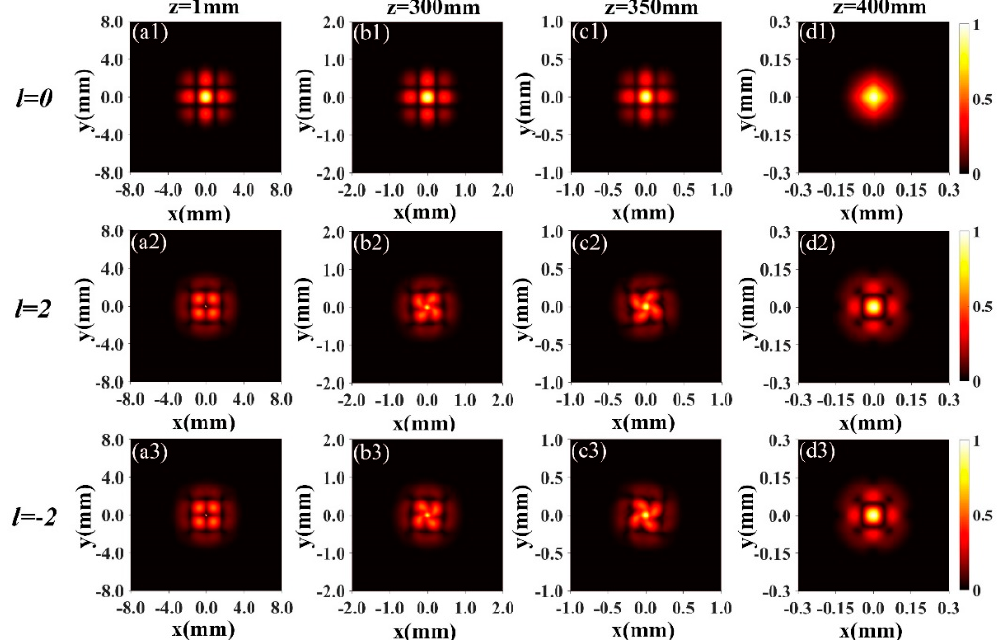
Figure 6. The modulus of the DOC ( | µ ( ρ ,0; z ) | ) of a focused HGCSMLG 0l beam at different distances with m = 1, n = 0 and increasing values of the TC.